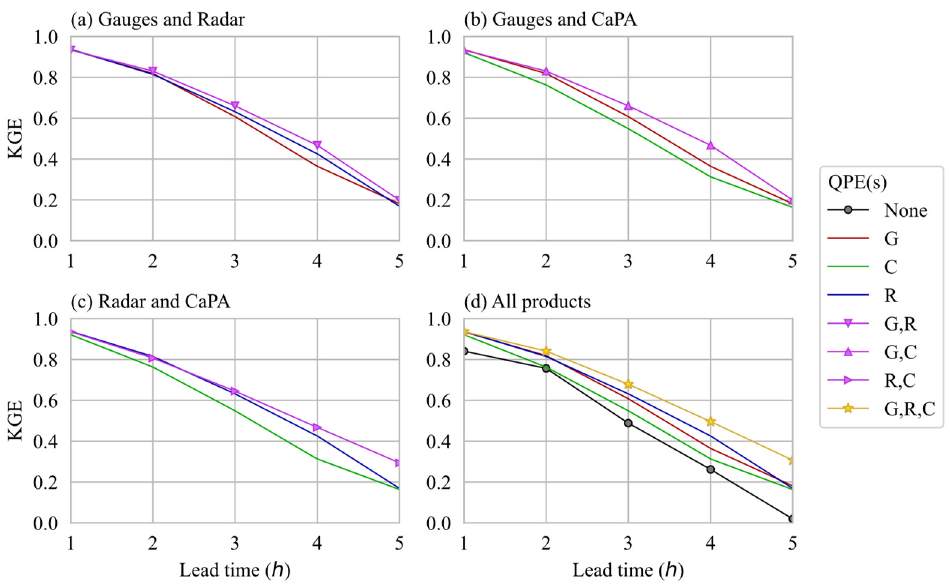
Figure 7. Mean KGE of the models that use, besides Q t − L and Q t − L − 1 , QPE from ( a ) gauges and radar, ( b ) gauge and CaPA, ( c ) radar and CaPA, and ( d ) all of them, including the no-QPE (None) used as benchmark.